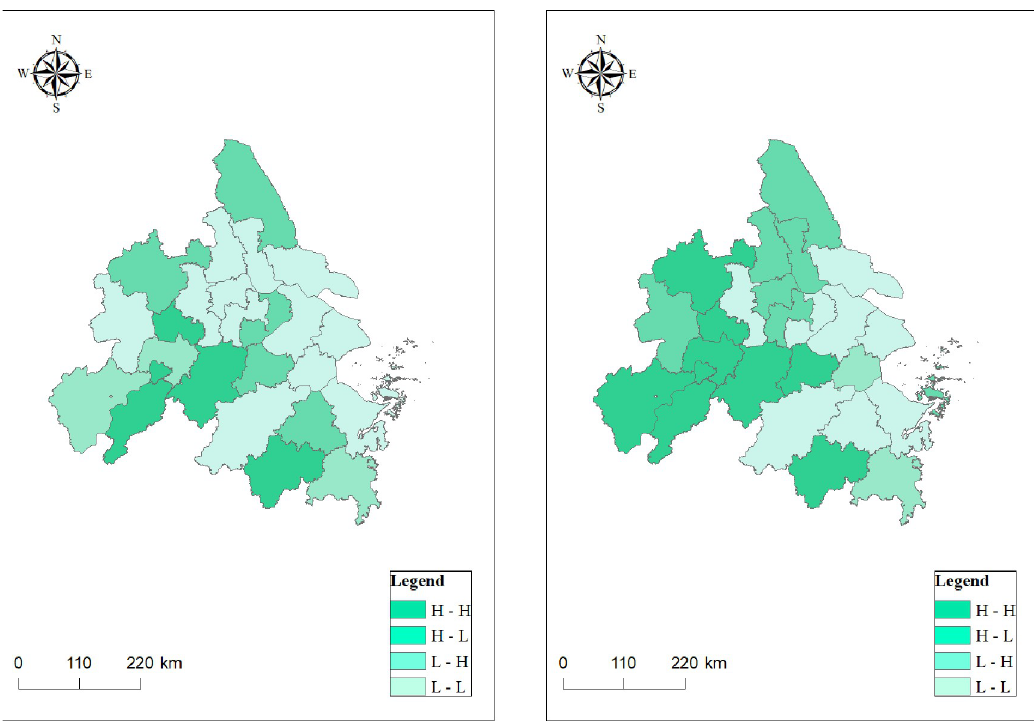
Fig 5. Lisa spatial clustering diagram of urban innovation and integrated transport efficiency in the Yangtze River Delta in 2019. (The data are estimated by the authors themselves and the figure is drawn by Arc GIS).